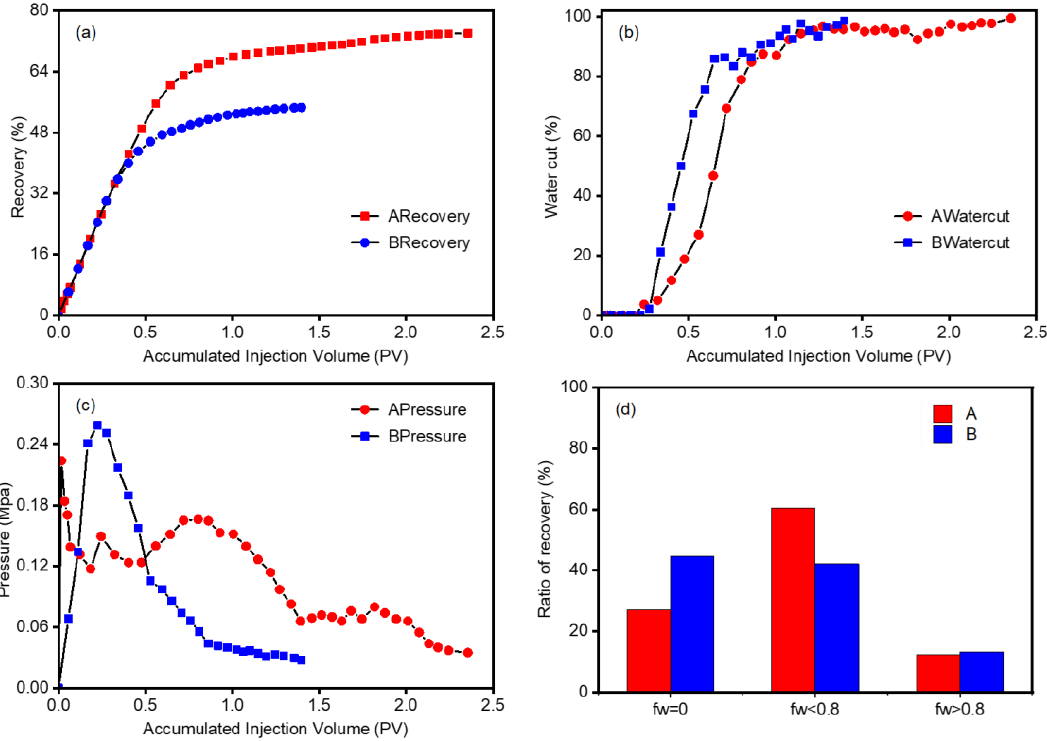
Figure 4. Recovery, water cut and pressure curves of heavy oil with different viscosities. ( a ) Recovery, ( b ) water cut, ( c ) pressure, ( d ) ratio of recovery.